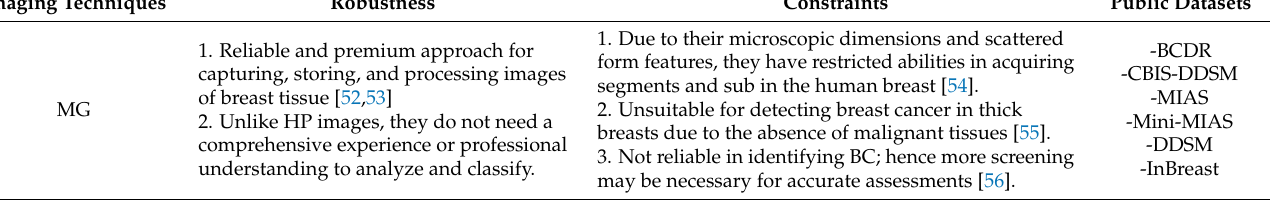
Table 1. Robustness and constraints of various imaging techniques for BC diagnosis and